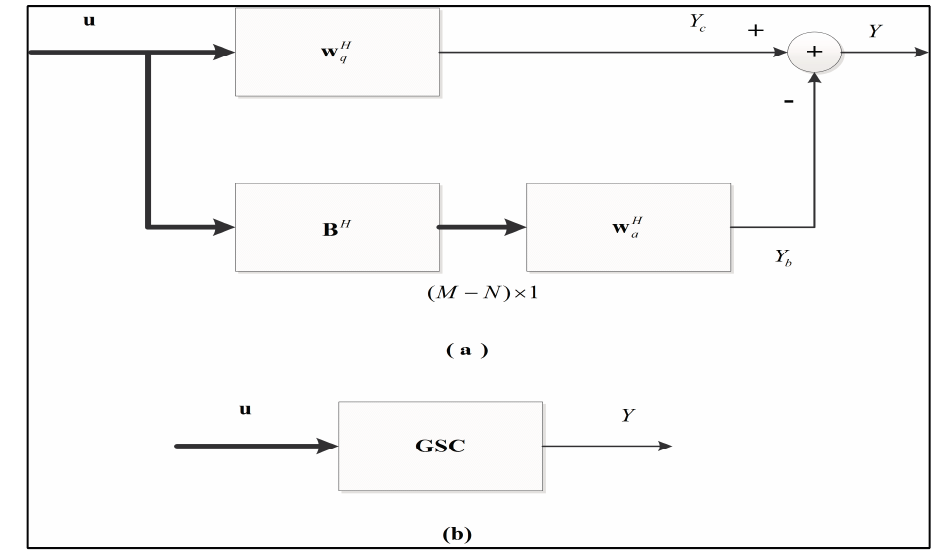
Figure 3. Generalized sidelobe canceller (GSC): ( a ) block diagram of GSC; ( b ) equivalent diagram of